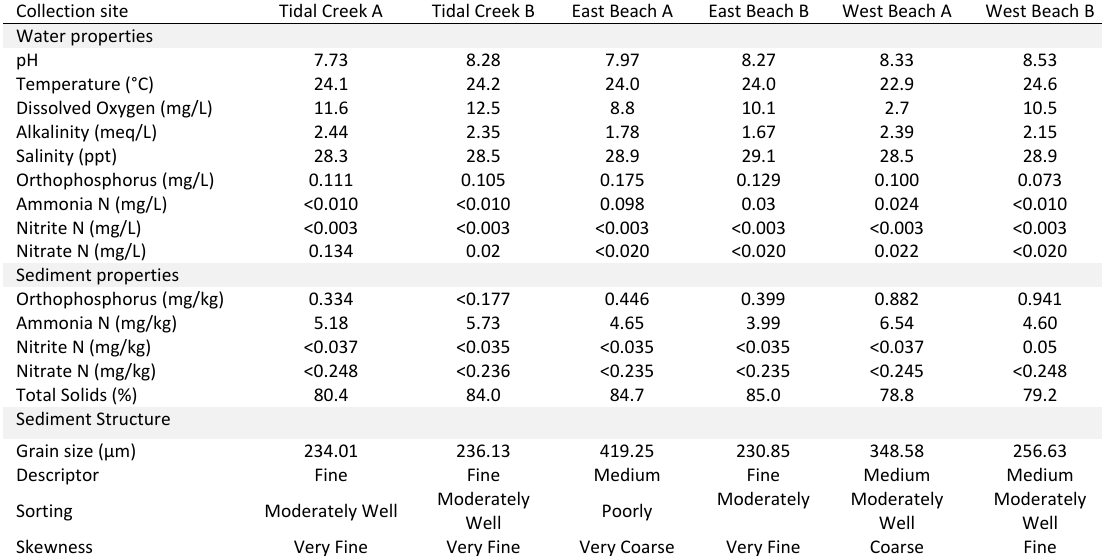
Table 1: Water and sediment properties taken on sediment collection day (July 6, 2017) and sediment structure (collected July 12, 2019). mg/L- milligrams/liter; mEq/L-milliequivalents/liter Ppt-parts per thousand;; mg/kg- milligrams/kilogram Collection site